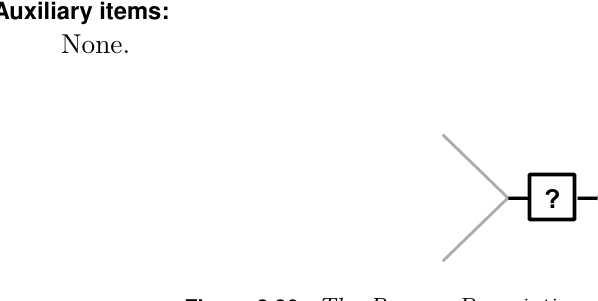
Figure 2.30: The Process Description glyph for an uncertain process